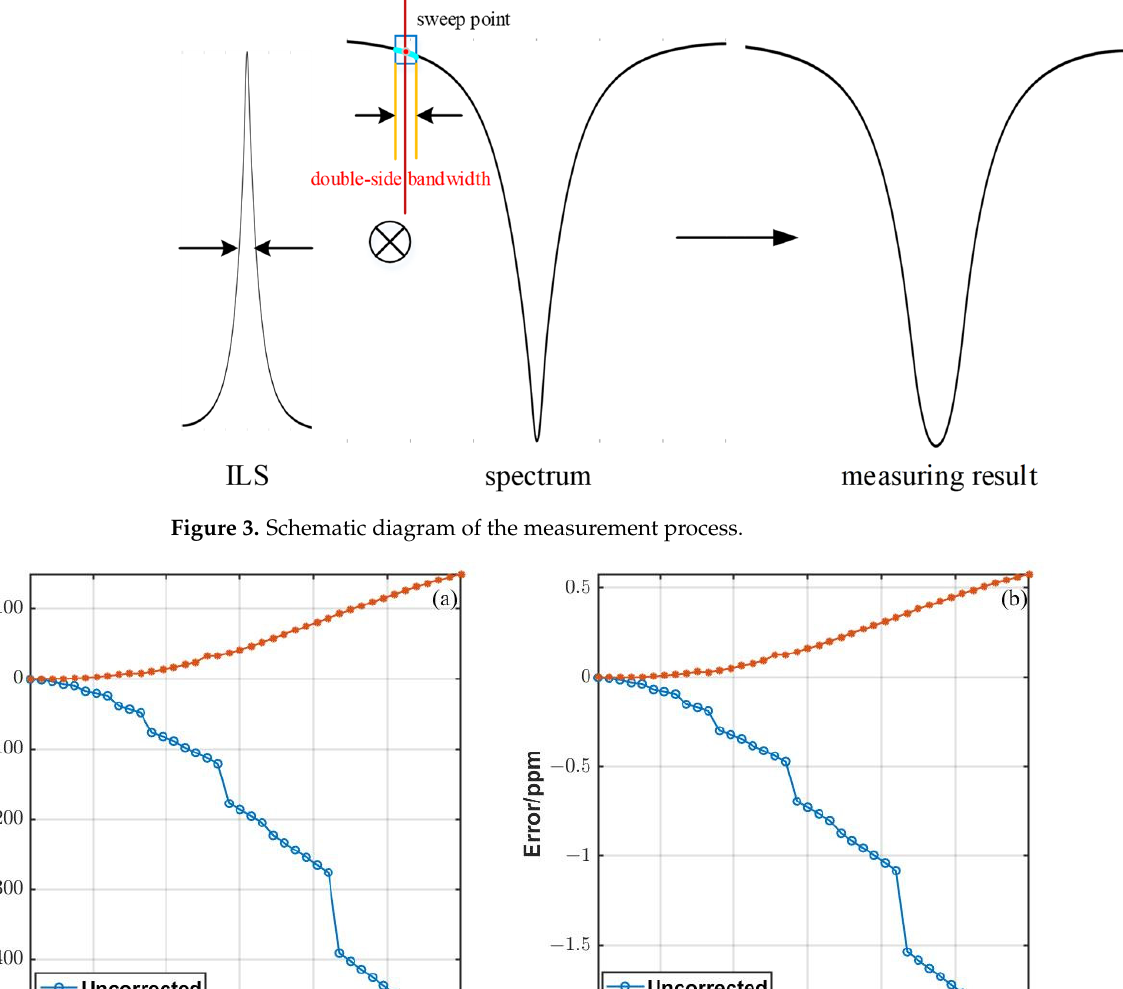
Figure 5. ( a ) Influence of wavelength shift on pressure error at different bandwidths. ( b ) Influence of wavelength shift on equivalent XCO 2 error at different bandwidths. 3.3. Influence of SNR According to the theoretical calculation and measurement, when the system is used for atmospheric CO 2 measurement, the SNR remains greater than 100 for bandwidths greater than or equal to 30 MHz. As the actual filter-bandwidth may be greater than the nominal bandwidth, 60 MHz bandwidth provides some leeway. The ideal 60 MHz band- pass-filter is chosen as the simulation basis for the next simulation, where the error